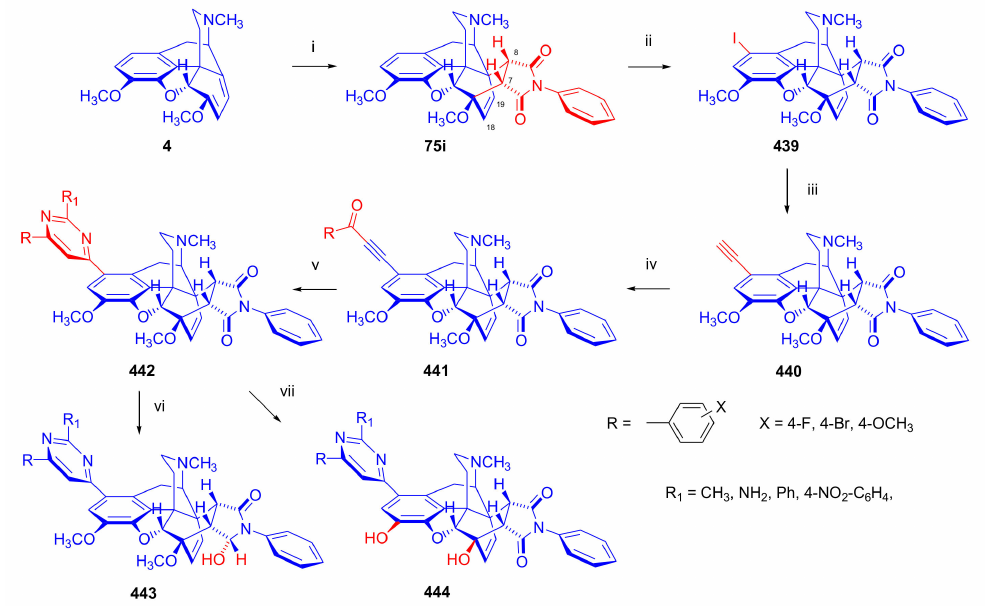
Figure 110. Synthesis of 1-pyrimidino-6,14-ethenomorphinans. Reagents and conditions : (i): N - phenylmaleimide, benzene, 80 ◦ C, 15 min, 68%; (ii): NIS, TFA, 2 h, RT; (iii): (1) trimethylsilylacetylene, Pd[(PPh 3 ) 2 ]Cl 2 , PPh 3 , CuI, Et 3 N, DMF, 70 ◦ C, 19 h, (2) Bu 4 NF, CH 2 Cl 2 , 15 min RT; (iv): Pd[(PPh 3 ) 2 ]Cl 2 , PPh 3 , CuI, Et 3 N, toluene, 70 ◦ C, 8 h, 60–77%; (v): cyclocondensation with (A) acetamidine HCl, Na 2 CO 3 , acetonitrile, 8 h, reflux, or (B) guanidine HCl, Cs 2 CO 3 , acetonitrile, 8 h, reflux, or (C) benzamidine HCl or 4-nitrobenzamidine HCl, K 2 CO 3 , acetonitrile, 8 h, reflux; (vi): NaBH 4 , THF, 60 ◦ C, 6 h, reflux, 60–80%; and (vii): 1M BBr 3 in CHCl 3 , CHCl 3 , 3 h, room temperature,